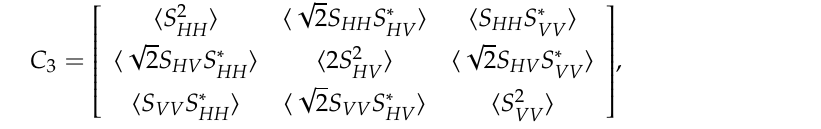
network for classification. network for